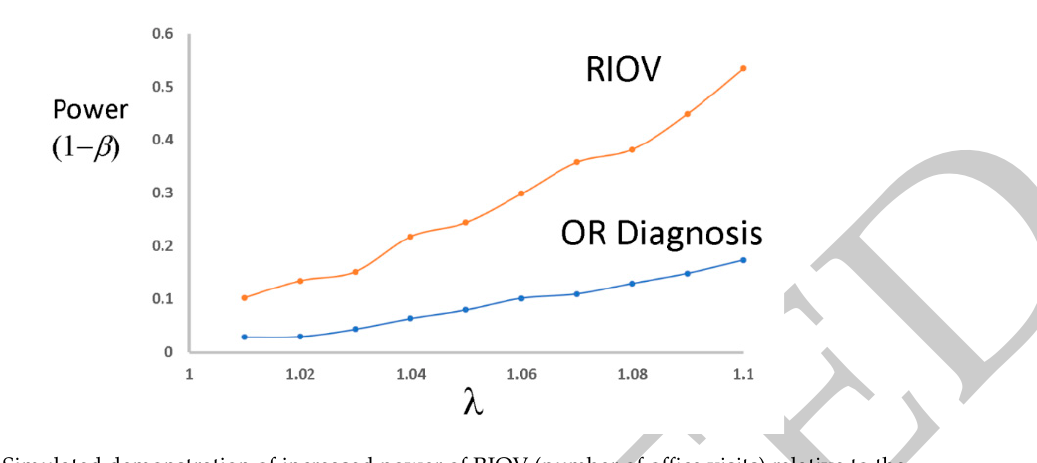
Figure 6. Simulated demonstration of increased power of RIOV (number of office visits) relative to the power of odds ratio of incidence of diagnoses (at least one office visit).